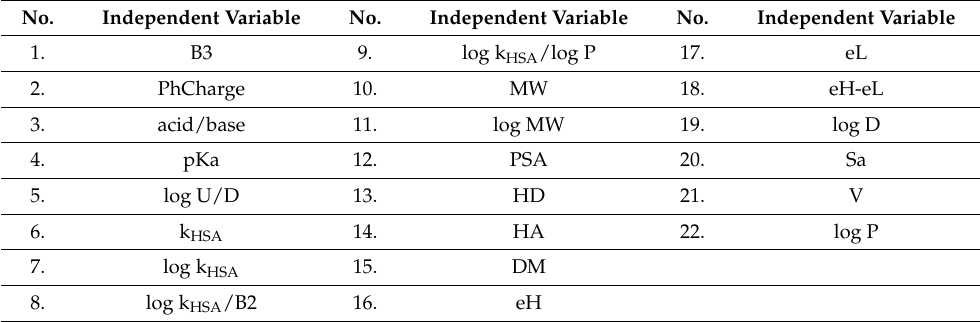
Table 4. Twenty-two independent variables with HPLC HSA data used to create the RF and PLS model for